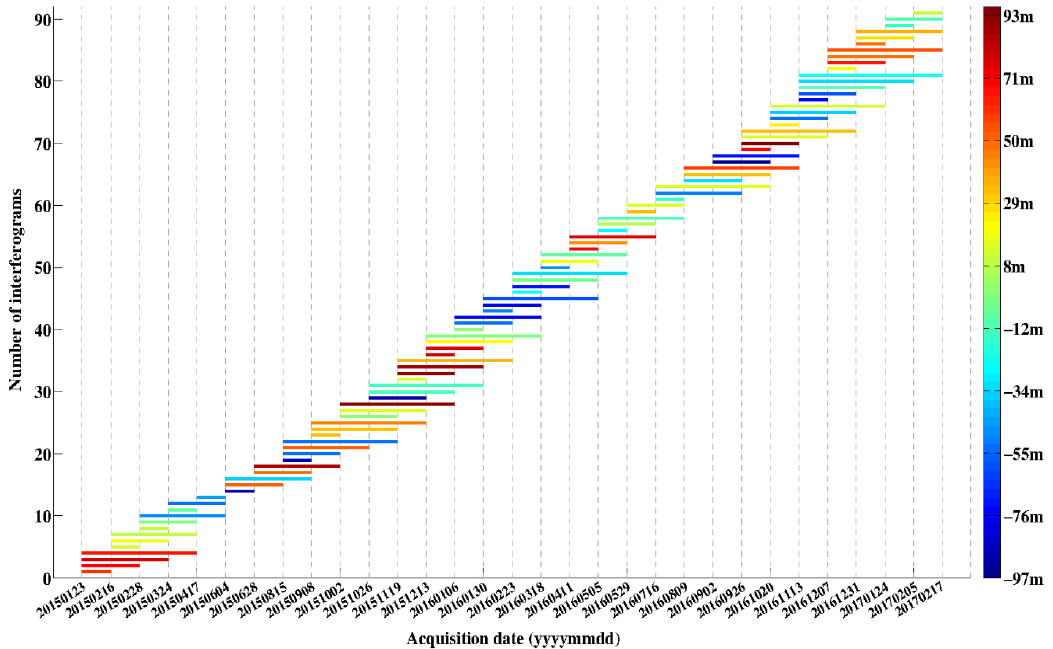
Figure A1. The distribution of the temporal and spatial baselines from Sentinel-1A with ascending orbit between 23 January 2015 and 17 February 2017.